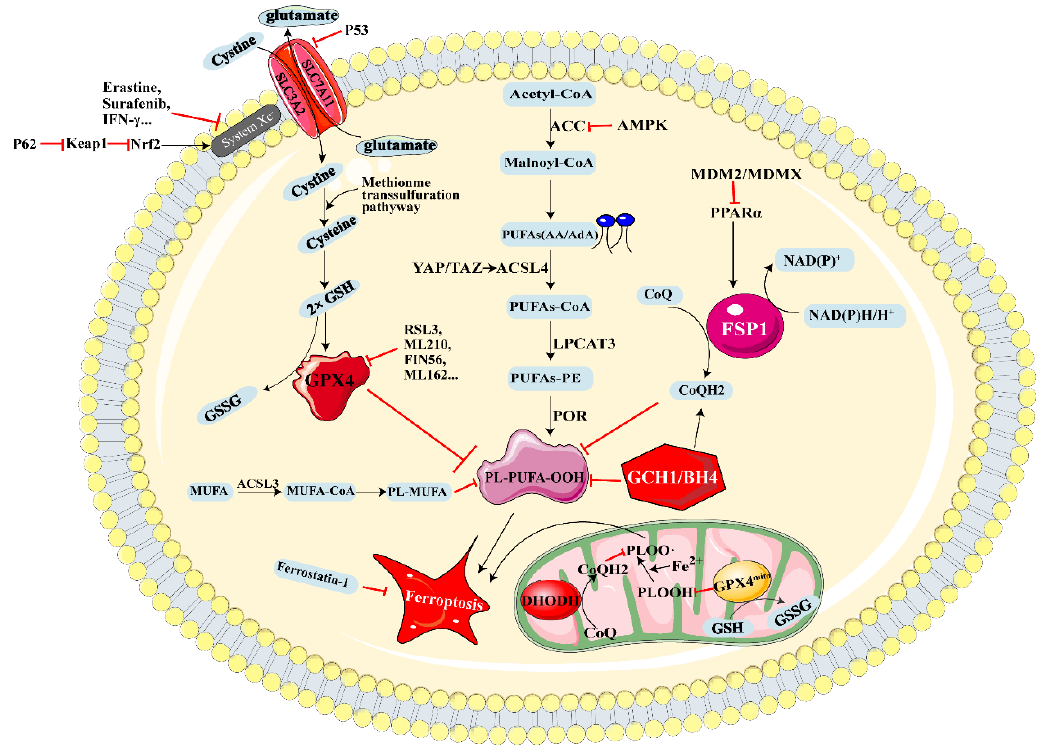
Figure 1. Summary of core regulators and main mechanisms of ferroptosis. The major systems regulating ferroptosis include GPX4-related ferroptosis defense, FSP1-associated system, GCH1/BH4-related system and DHODH-mediated ferroptosis resistance. The core components and regulators